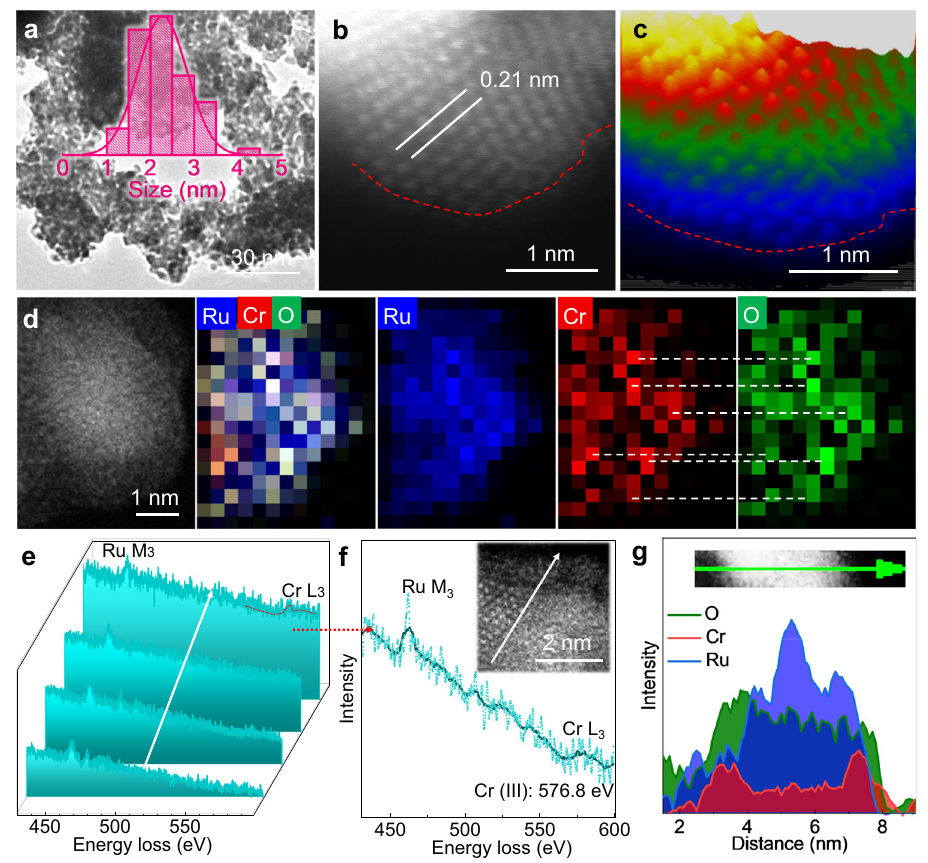
Fig.2|StructuralcharacterizationsofRu – Cr 1 (OH) x .a TEMimage.Insetisthesize distribution of nanoparticles. High-resolution HAADF-STEM image ( b ) and the corresponding pseudo-color surface plot ( c ). d EELS mapping images. The line scanningEELSspectra( e )andtheenlargedEELSspectrafortheedgeofRuparticle